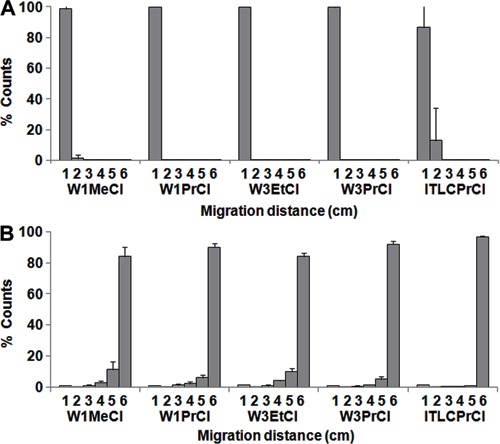
Chromatography of 99mTcO4
- (A) and
[99mTc(MIBI)6]+(B) reported
as percent of counts in segments of the chromatographic strip (cm), numbers 1 to
6. The following chromatographic systems were used: (W1MeCl) W1
paper/methanol:chloroform (25:75), (W3EtCl) W3 paper/ethanol:chloroform (25:75),
(W1PrCl) W1 paper/propanol:chloroform (25:75), (W3PrCl) W3
paper/propanol:chloroform (25:75), and (ITLCPrCl) ITLC-SG/propanol:chloroform
(25:75). Data are reported as means±SD for n=18.